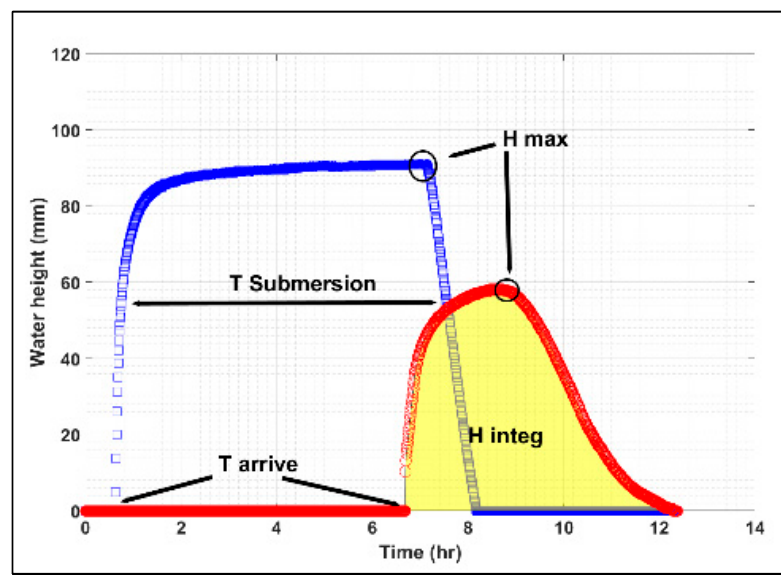
Figure 2. Time evolution of water levels during an irrigation event in two locations monitored in the 1st site. The first blue curve was obtained in the upstream section of the field, and the second red curve in the downstream section of the field. Proxy-variables used in fitting process are given on this figure.